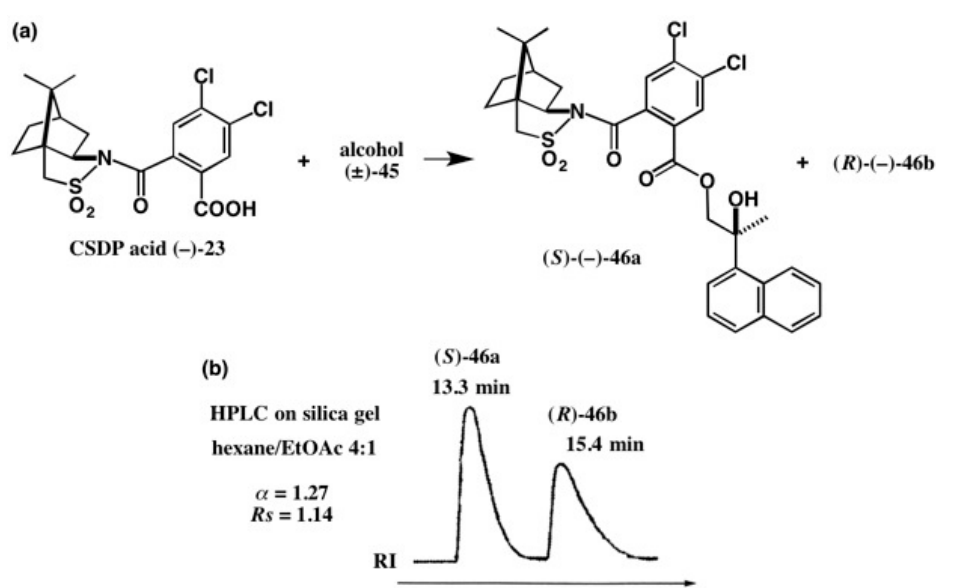
Figure 31. Preparation ( a ) and HPLC separation ( b ) of CSDP esters 46a and 46b . HPLC, reprinted from [42].